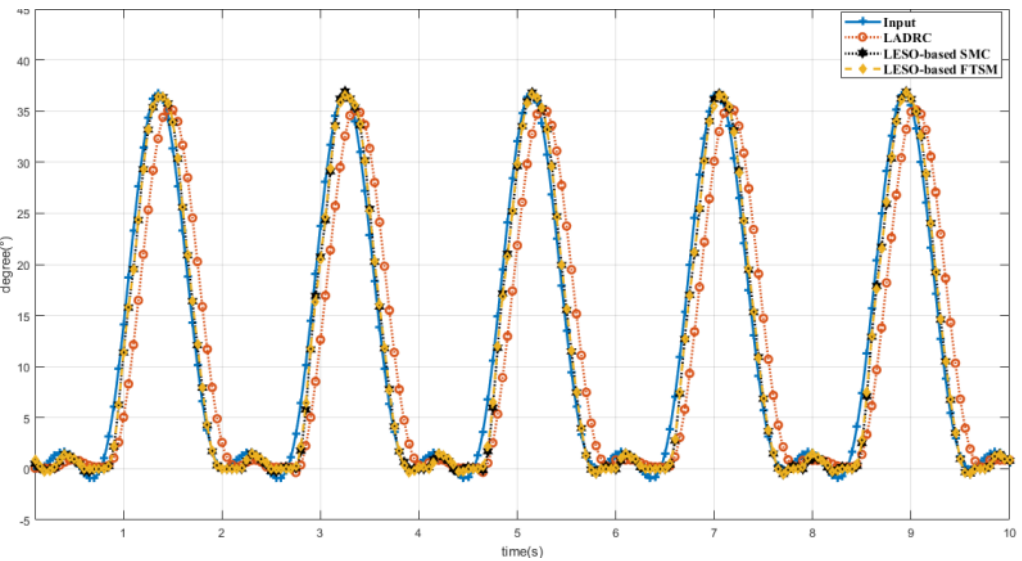
Figure 10. Trajectories of hip joint at walking speed = 0.225 m/s.